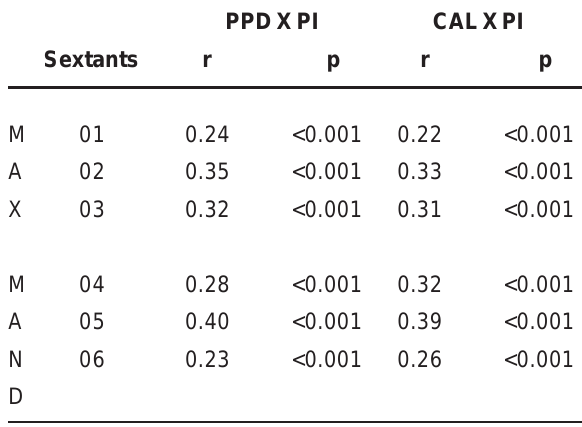
TABLE 3- Correlation between PPD and PI and between CAL and PI by sextant